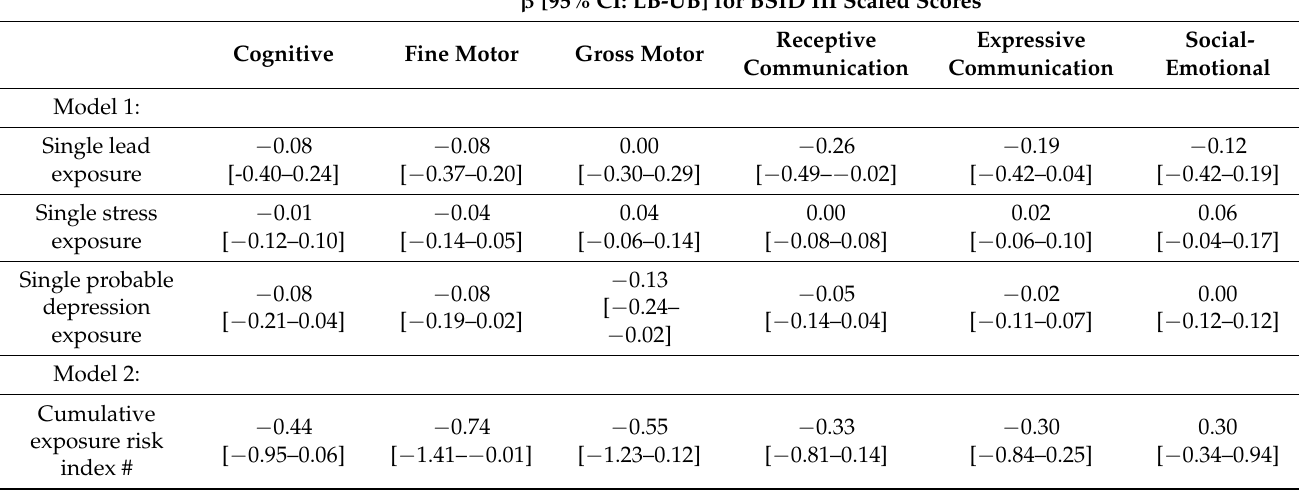
Table 3. Adjusted linear regression models for single and cumulative exposure to lead, perceived stress, and probable depression based on BSID III scaled scores.